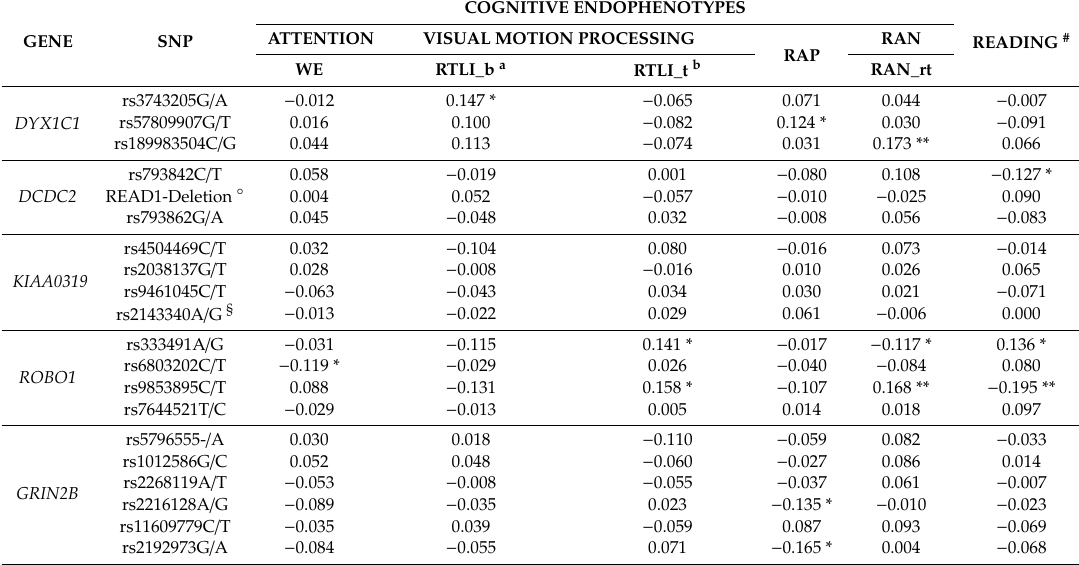
Table 2. Correlation among candidate genes, cognitive endophenotypes and reading composite score in the total sample ( n =